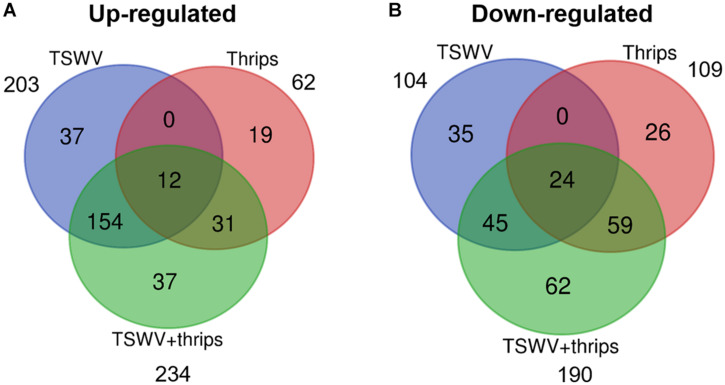
Venn diagrams depicting number of unique and shared differentially-expressed (A) up-regulated and (B) down-regulated genes. Data were obtained from differentially-expressed genes in tomato plants systemically-infected with TSWV and/or infested with F. occidentalis. Numbers outside of circles indicate the total number of differentially-expressed genes for a particular treatment.